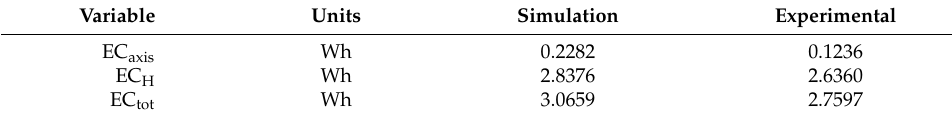
Table 5. Summarized simulation and experimental results of energy consumption.